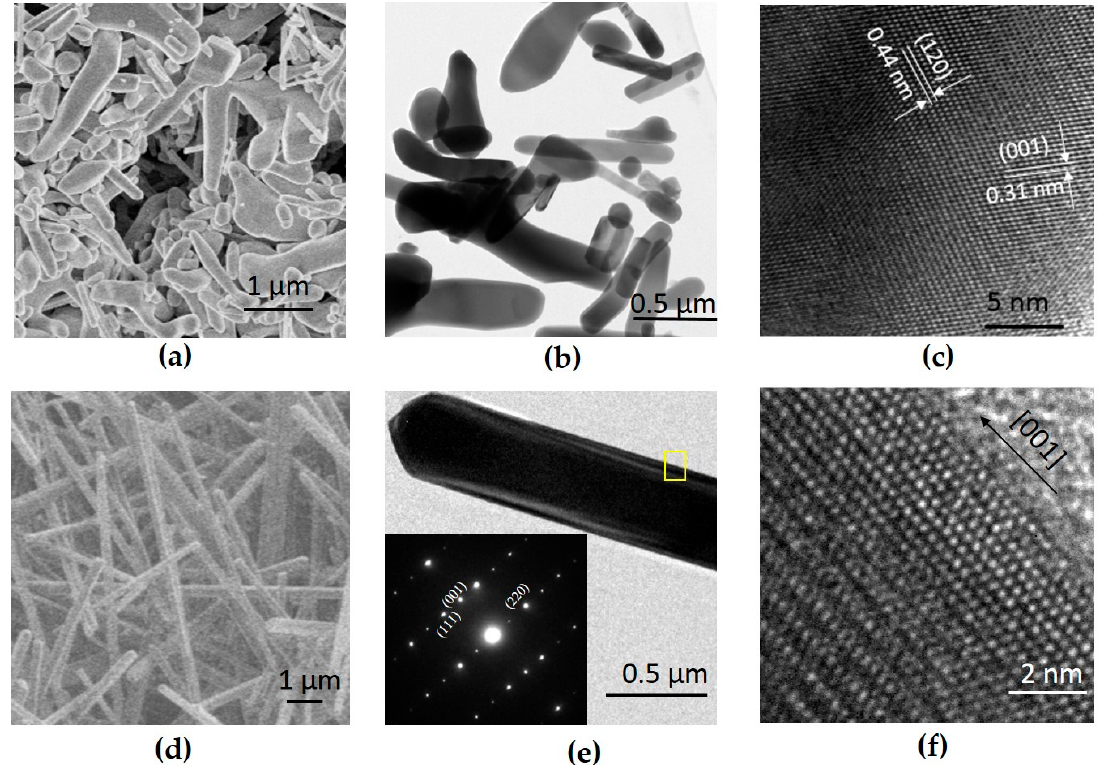
Figure 2. Electron micrographs of CaMn 2 O 4 powder made by mechanochemical processing and subsequent heat treatment, ( a ) SEM, ( b , c ) TEM; CaMn 2 O 4 powder made using a hydrothermal method, ( d ) SEM and ( e , f ) TEM. The inset in Figure (e) is an electron diffraction pattern taken in the area indicated with a yellow square.